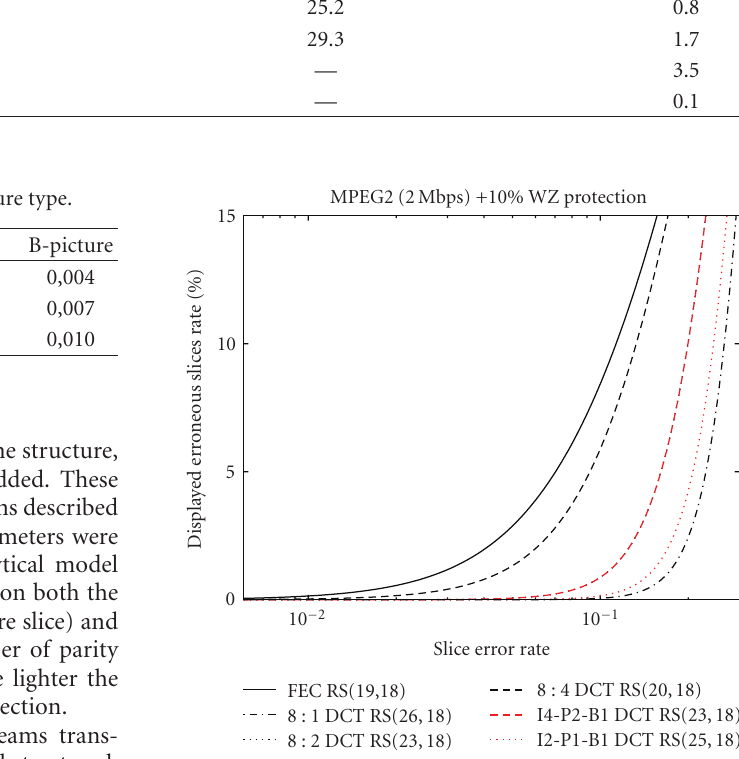
Figure 4: Evolution of the displayed erroneous slices rate after RS correction as a function of the incoming slice error